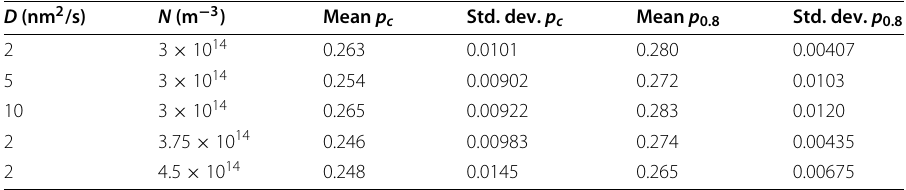
Table 3 Mean percolation threshold ( p c ) and mean porosity at which f V = 0.8 ( p 0.8 ) for the five initial condition configurations considered, and corresponding standard deviations, for each set of simulation